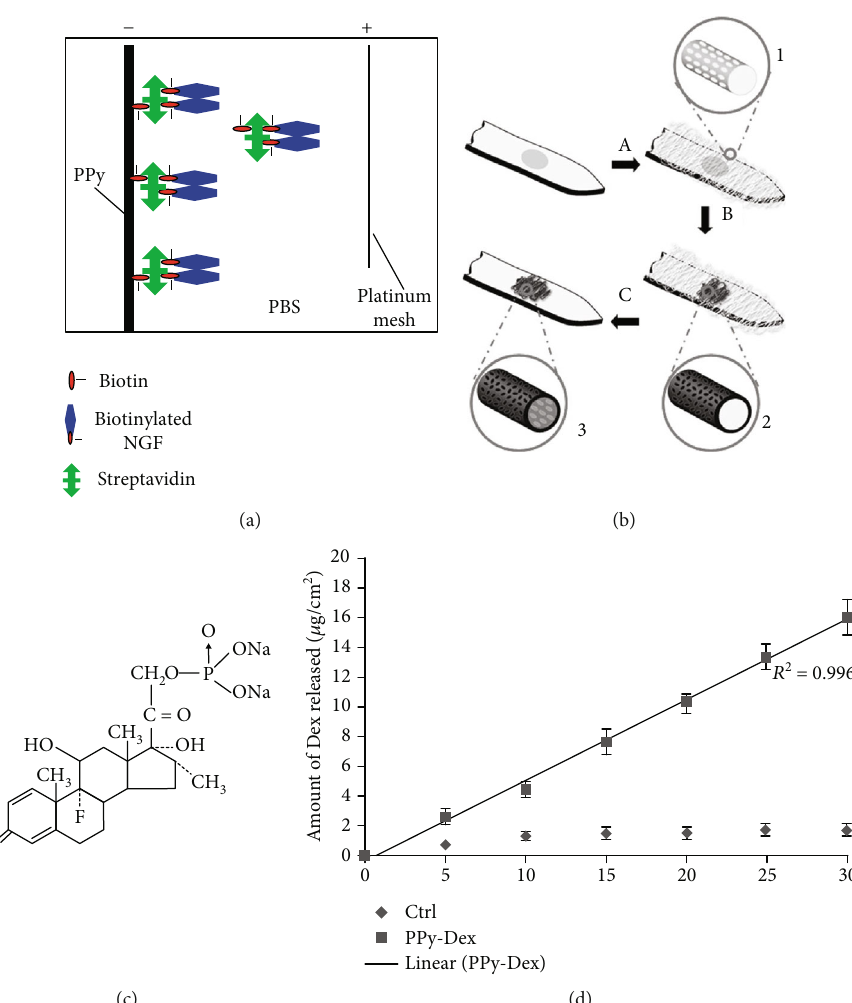
Figure 1: Schematic illustrations of the modi fi cation of conducting polymers and prodrug for drug delivery systems: (a) release of the biotin from the PPy surface; [45] (b) surface modi fi cation of neural microelectrodes to create nanotubular PEDOT; [43] (c) chemical structures of the dexamethasone disodium phosphate (Dex); [41] (d) release pro fi le of Dex from the polymer-drug-coated electrodes [41].